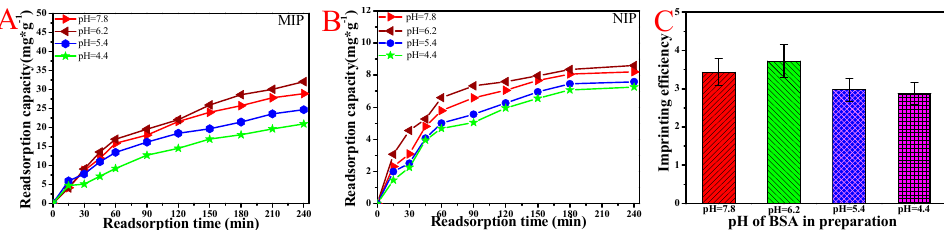
Figure 5. The rebinding capacity ( A ) and imprinting efficiency ( C ) of molecularly imprinted polymer (MIP) prepared under different BSA pH values; the rebinding capacity ( B ) of non-imprinted CaAlg hydrogel membrane (NIP) prepared under different water solution pH values. NaAlg concentration: 2.5 wt%; copper wire diameter: 0.3 mm; and pH of Tris-HCl: 8.1.